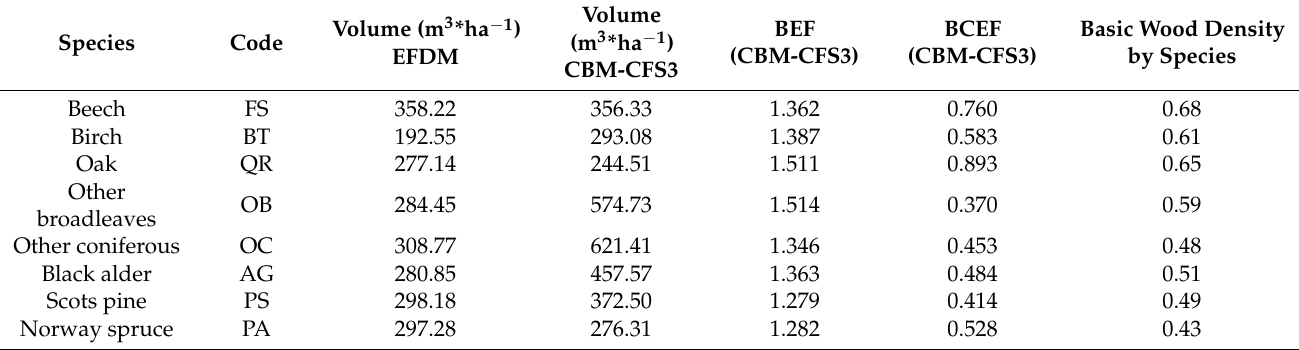
Table 2. Comparison of growing stock by species for the baseline condition and summary of indices derived from the CBM-CFS3.